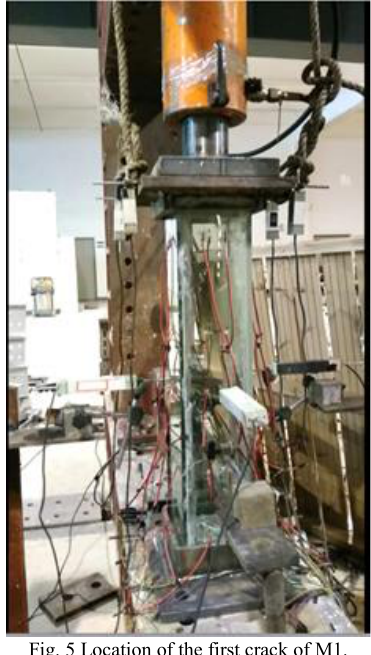
Fig. 5 Location of the first crack of